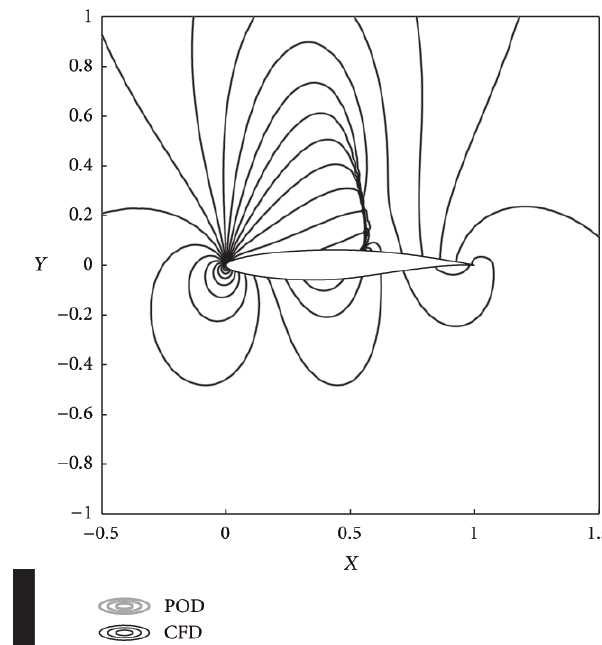
Figure 4: Pressure contours. Reconstruction at Mach = 0.725 and A . O . A . = 3.25